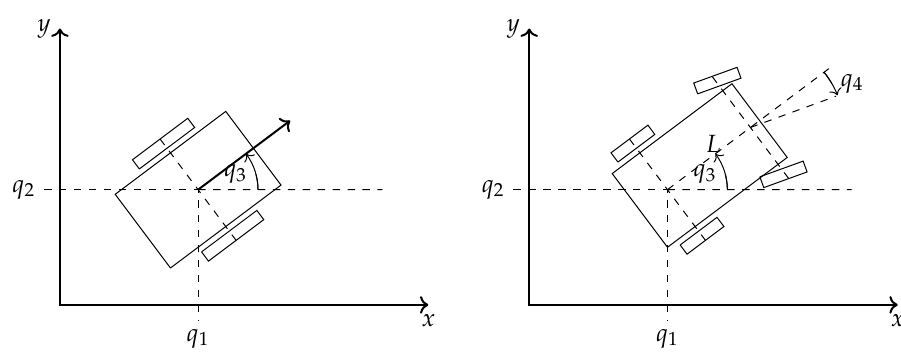
Figure 1. The unicycle ( left panel) and the kinematic car ( right panel). For both models, the position on the xy plane was selected as the output